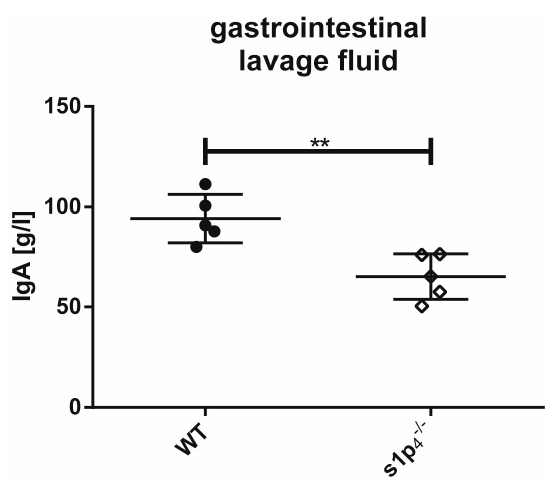
Figure 4. Immunoglobulin A (IgA) levels in gastrointestinal lavage fluid. IgA levels in gastrointestinal lavage fluid (GILF) were determined by enzyme-linked immunosorbent assay (ELISA) ( n = 4–5 per group). ** p < 0.01.